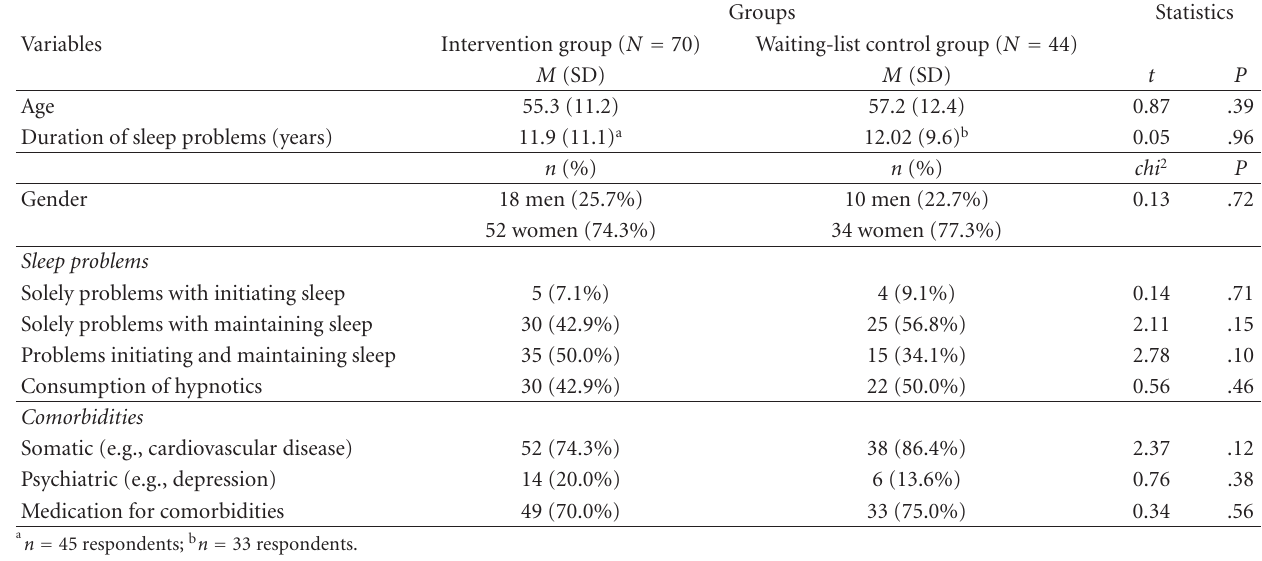
Table 1: Baseline characteristics of the study samples.